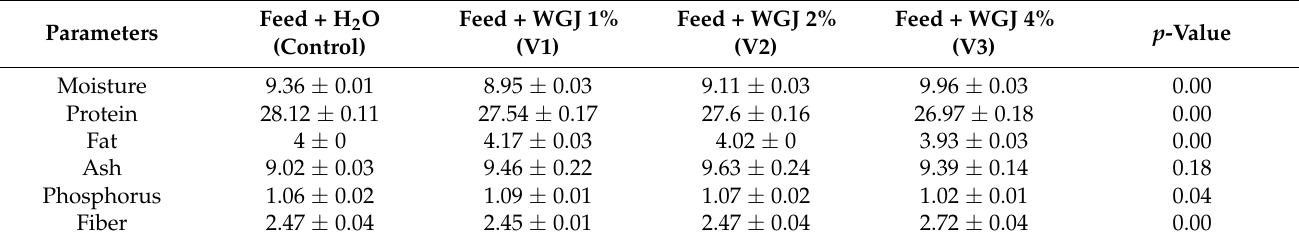
Table 2. Feed composition (Aller classic, pellet size 3